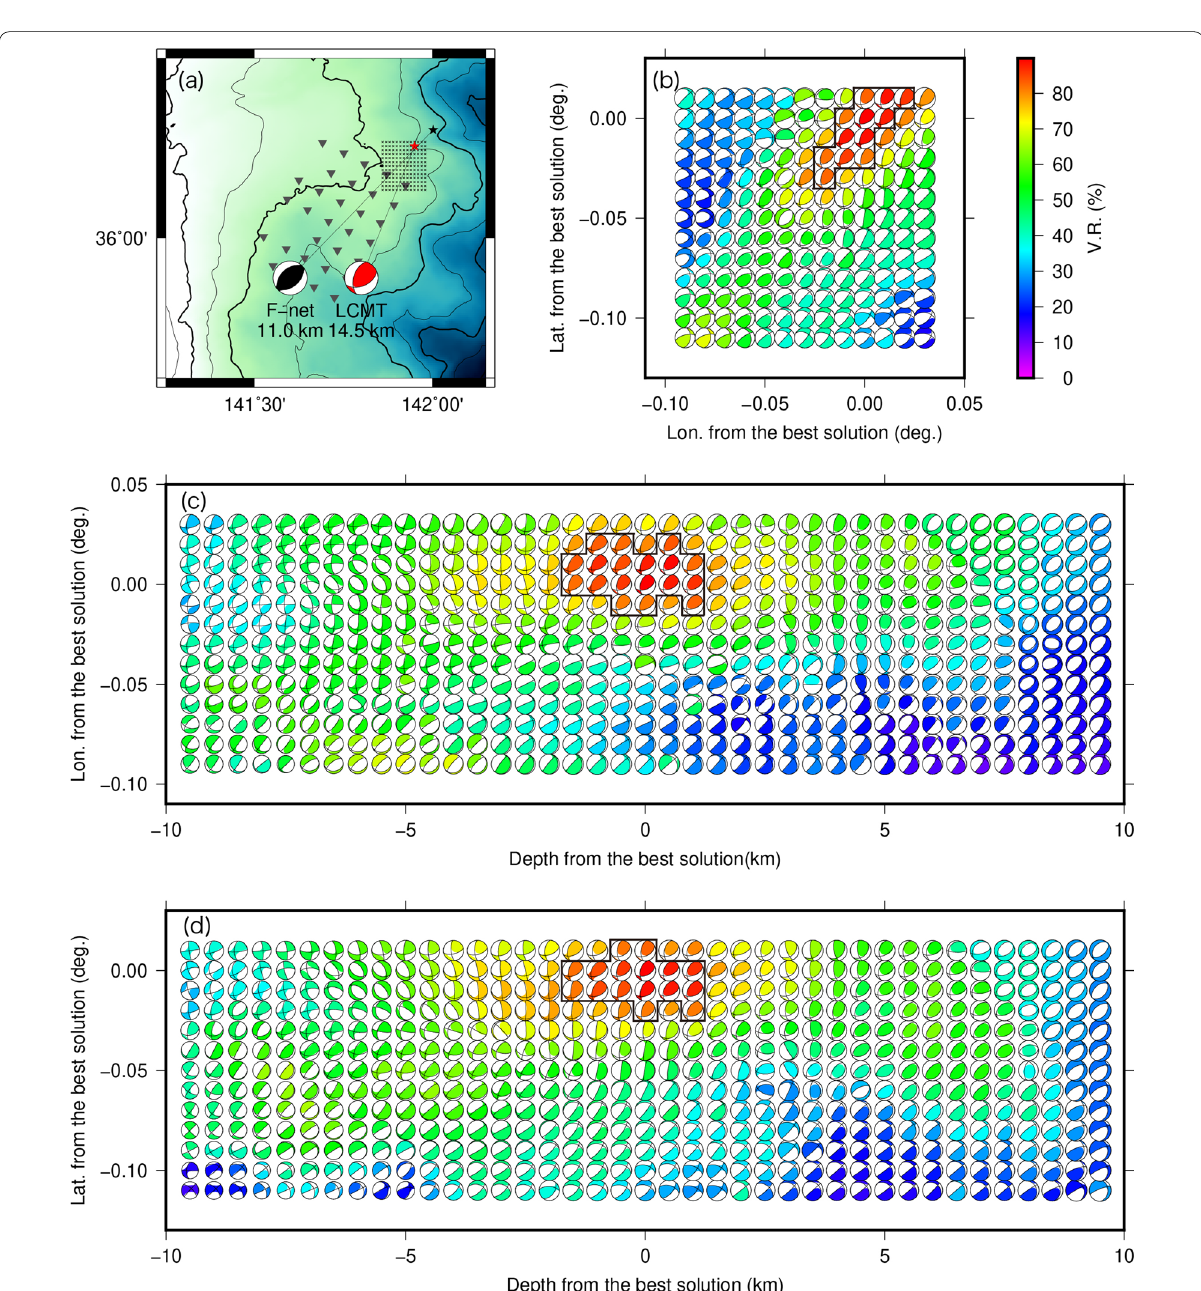
Fig. 3 Result of the CMT inversions for the earthquake (Mw 4.0) that occurred at 9:06, March 16, 2011 (JST). a Centroid location of the earthquake and the OBS array. The red star shows the horizontal location of the best centroid with 14.5 km depth. The red focal mechanism shows the moment tensor of the best CMT solution. The black star indicates the horizontal location of the F-net MT solution with 11.0 km depth. The black focal mechanism shows the moment tensor of the F-net MT solution. The grey triangles show the stations of the OBS array. b Horizontal resolution of the CMT solution. The color of the focal mechanisms shows the VR. The region surrounded by the black line shows VR more than 90% from our best. c Depth resolution with longitudinal direction, and d with latitudinal